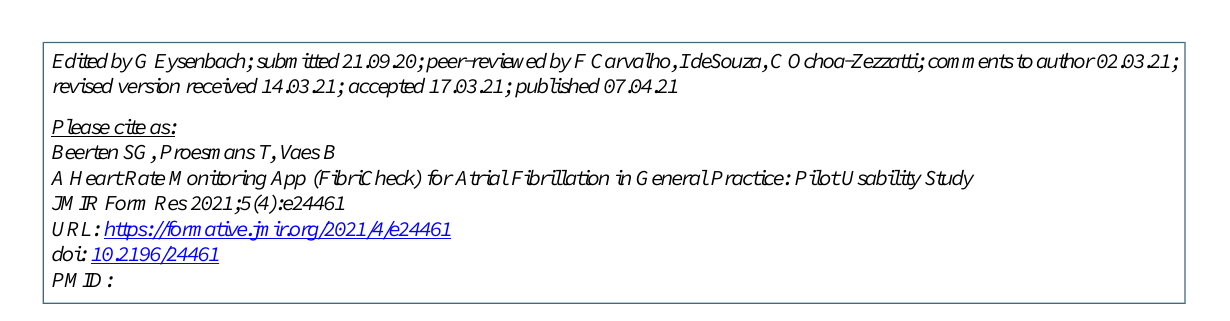
SEM: standard error of